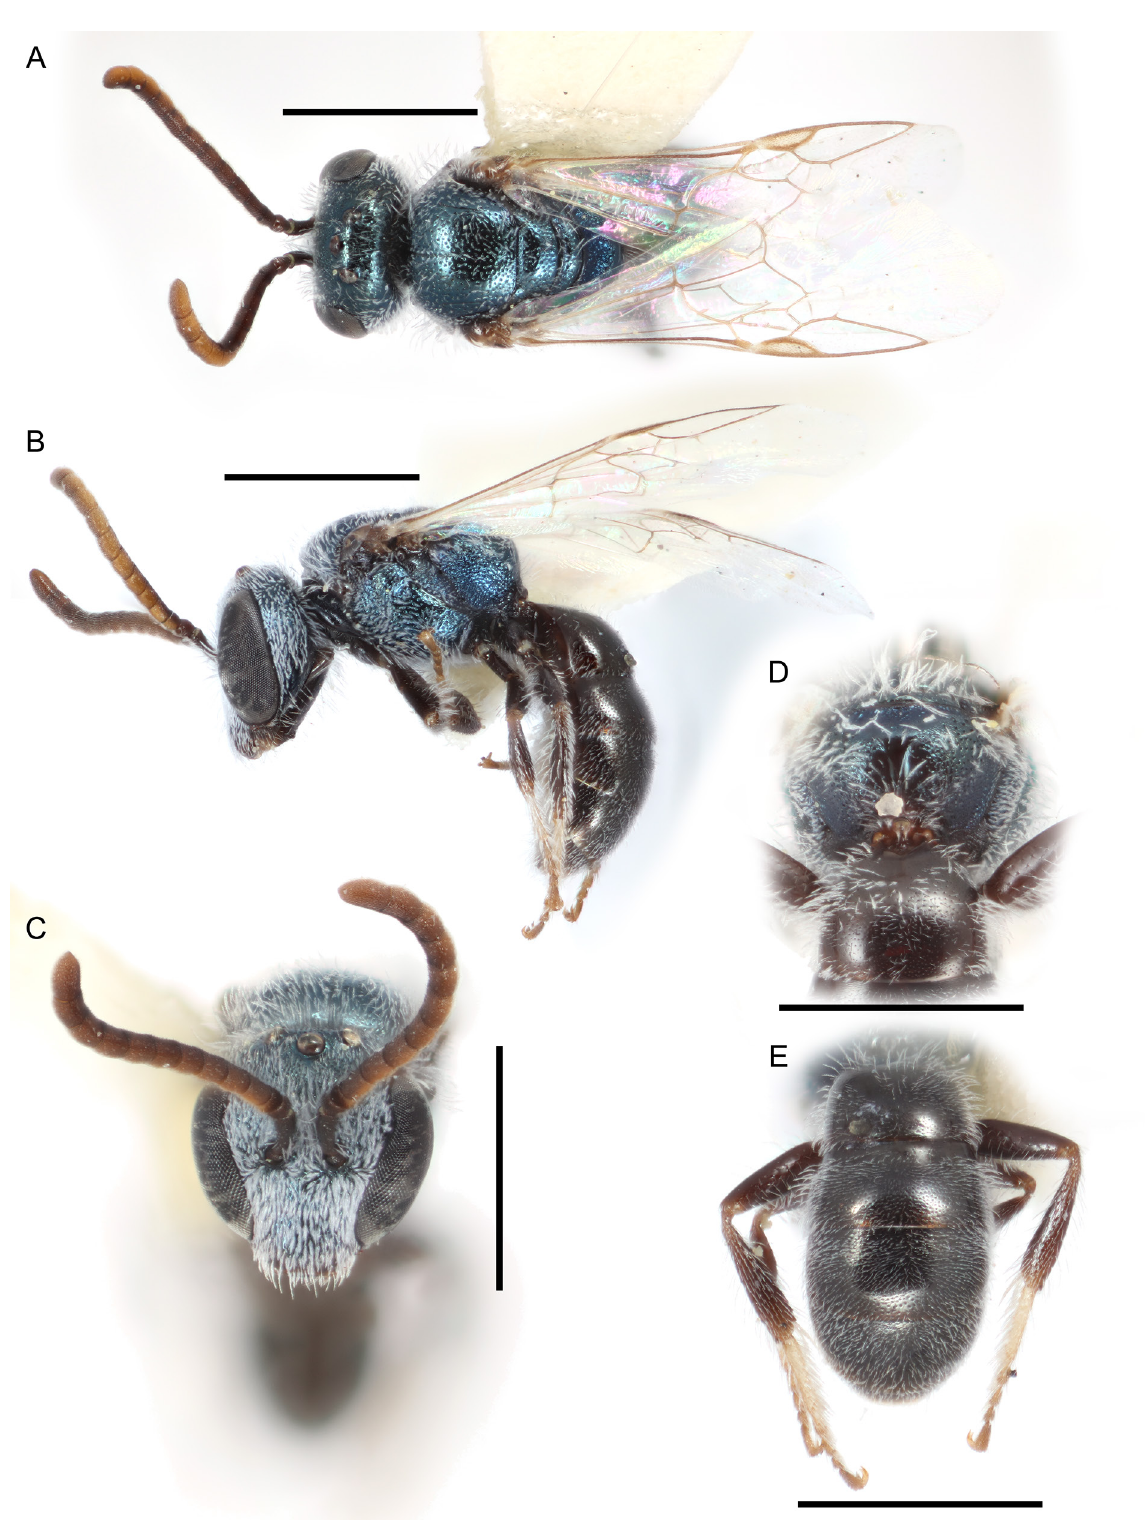
Fig. 79. Lasioglossum ( D. ) spivakae sp. nov., ♂. A . Dorsal habitus. B . Lateral habitus. C . Face. D . Propodeum. E . Metasoma. Scale bars: 1